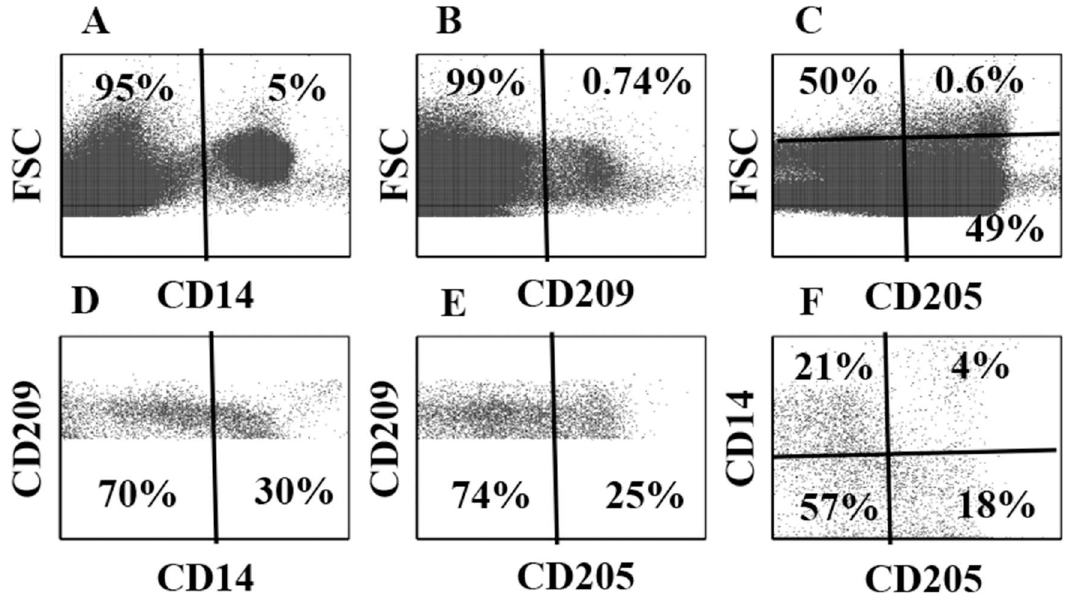
Fig 2. Three mAb comparison of co-expression of CD14 and CD205 on CD209 + bDC. A , B , C. Display in FSC vs fluorescence showingproportion of CD14 + , CD209 + , CD205 + cells present in PBMC with selective gates on G1 and G2 . D. Displaywith a selective gate on CD209 + bDC showingthe proportion of CD209 + bDC co-expressing CD14. E. The same display with the selective gate on CD209 + cells showingthe proportion co-expressing CD205. F. the same selective gate on CD209 + with a display comparingthe proportions of CD209 + cells expressing only CD14 or CD205 or co- expressing CD14 and CD205.